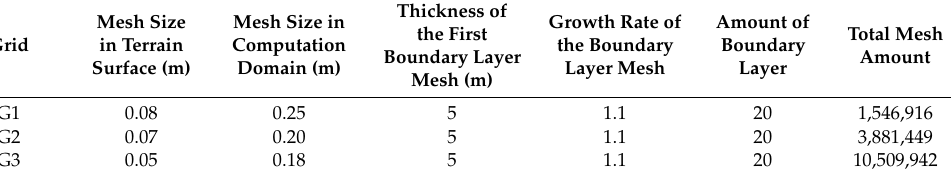
Table 3. Detailed setups of three grids of terrain model without BTS.